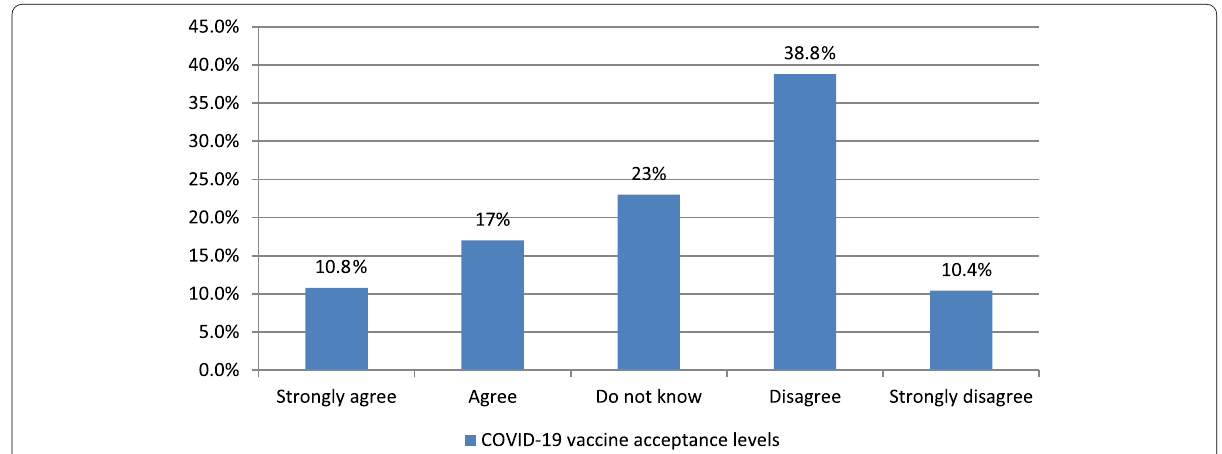
Fig. 2 Vaccine acceptance levels among the participating healthcare workers from Ismailia, Egypt in the 1st half of 2021 ( n